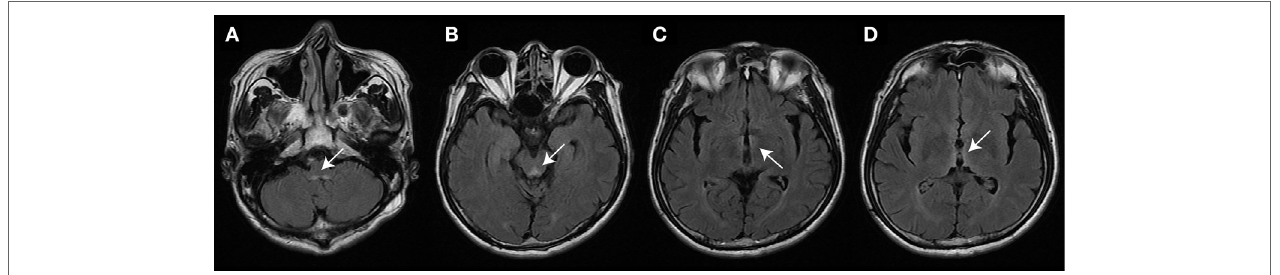
FigUre 1 | Brain magnetic resonance image (patient #1) studies (fluid-attenuated inversion recovery images) show bilateral symmetrical lesions (as marked by white arrows) in the medial vestibular nucleus (a) , the periaqueductal region (B) , around the hypothalamus and mammillary bodies (c) , and the periventricular regions of the thalamus (D)